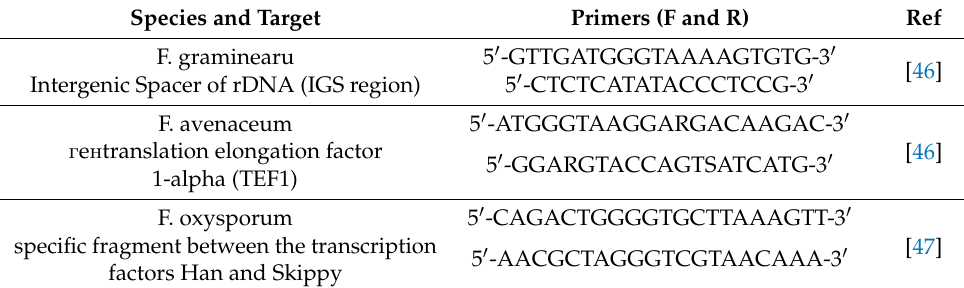
Table 6. Primers used to Fusariun sp. identification. Species and Target Primers (F and